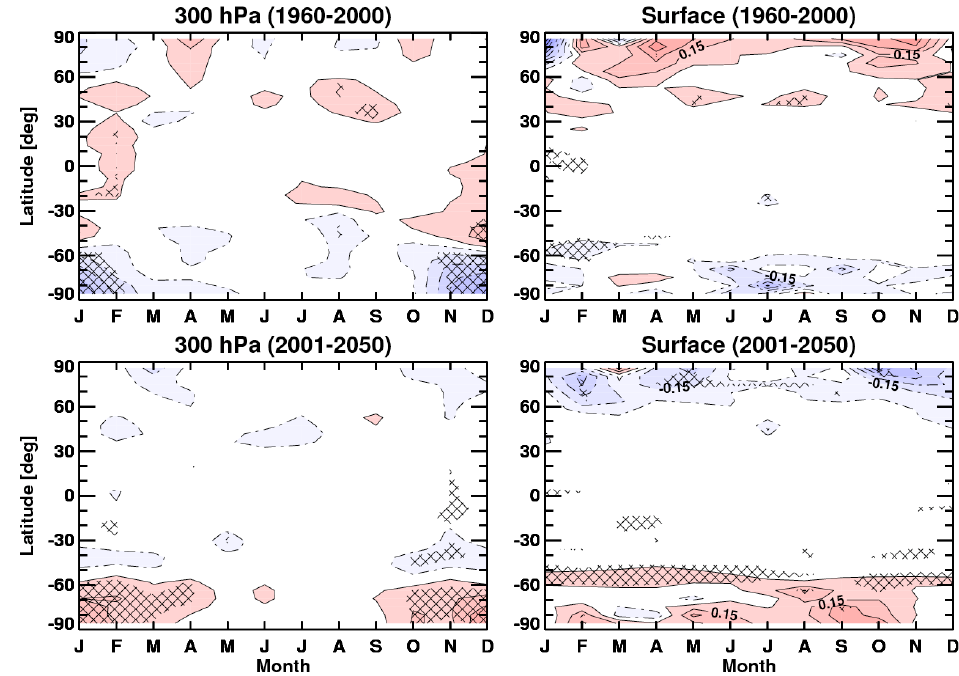
Fig. 3: Zonal mean temperature trend versus month and latitude for REF-B2 minus GHG 2 Fig. 3. Zonal mean temperature trend versus month and latitude for REF-B2 minus GHG for 1960–2000 (top) and 2001–2050 (bottom) at 300hPa (left) and at the surface (right). Contour interval is 0.1Kdecade − 1 , with red denoting positive values and blue negative. Trend for 1960-2000 (top) and 2001-2050 (bottom) at 300 hPa (left) and at the surface (right). 3 magnitudes less than 0.05Kdecade − 1 are not plotted. Cross hatching denotes regions where the 95% significance level is exceeded. Contour interval is 0.1 K decade -1 , with red denoting positive values and blue negative. 4 Trend magnitudes less than 0.05 K decade -1 are not plotted. Cross hatching denotes 5 H11 is absent in our results. Although there are patches of regions where the 95% significance level is exceeded. 6 past warming and future cooling in the NH, which are con- sistent with the NH average results shown in Fig. 2, they are not statistically significant when considered regionally and